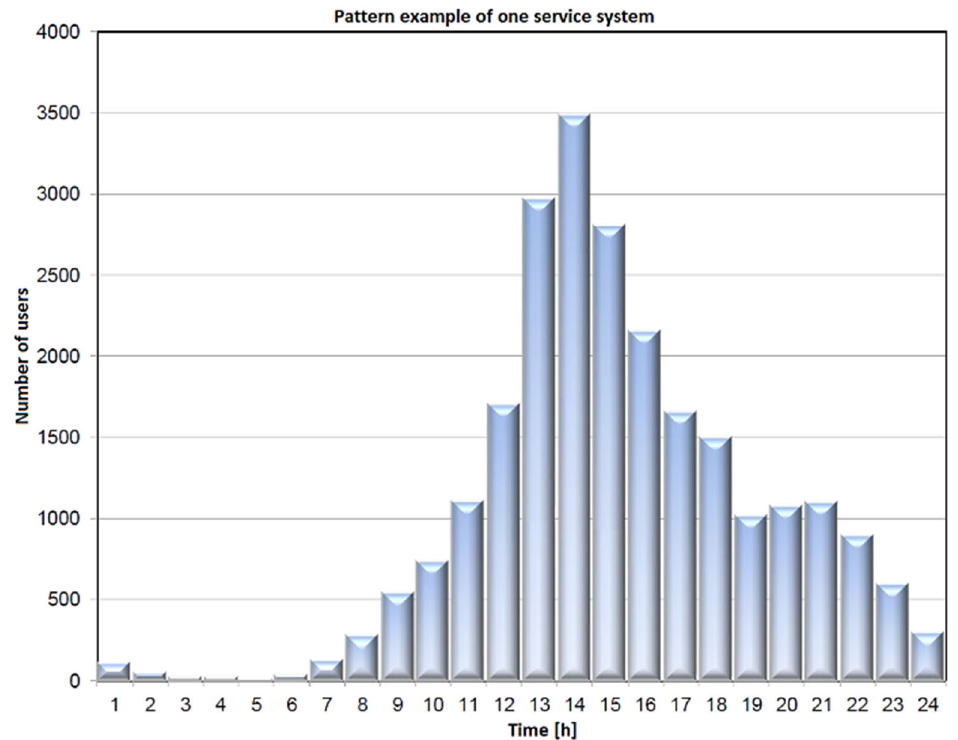
Figure 2. Example and illustration of actual demands on Margento service system.